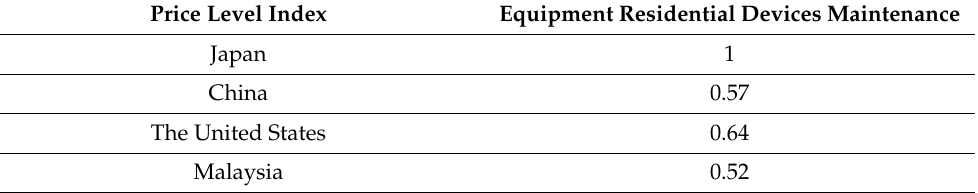
Table A4. Comparison of price levels between nations, with Japan set as 1 (Ministry of Internal Affairs and Communications,